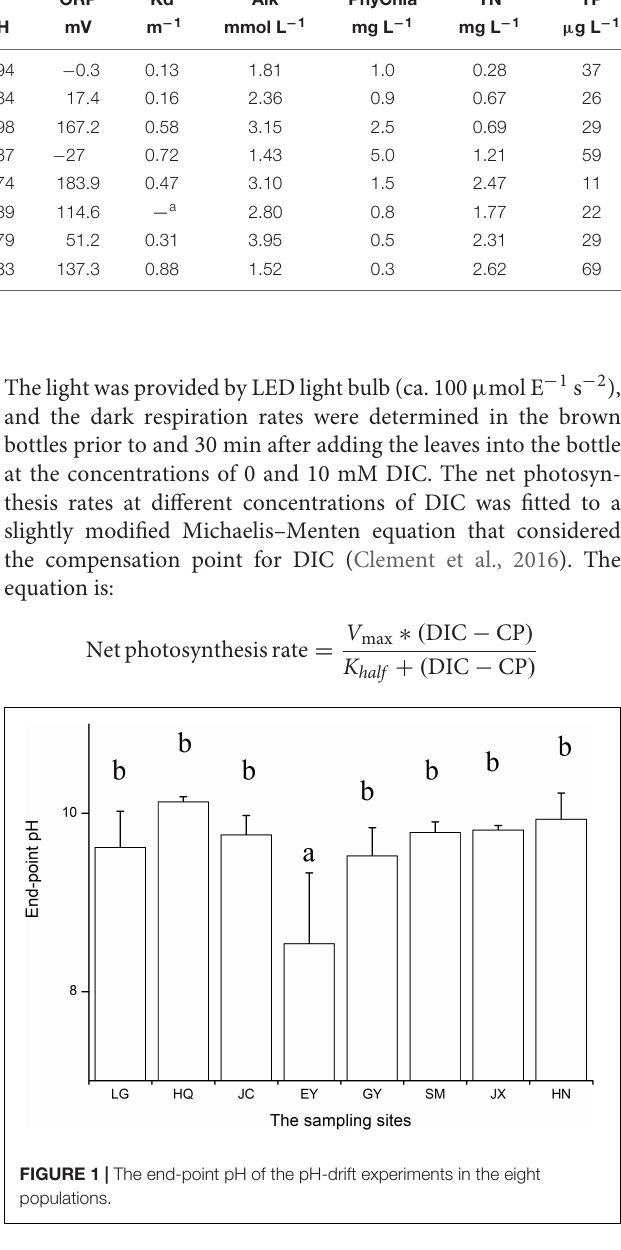
TABLE 2 | The physic-chemical variables of the sampling sites. Sampling